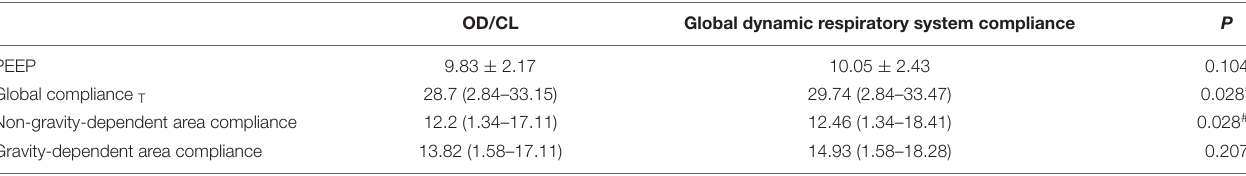
TABLE 2 | The comparison between the global compliance and regional compliance at PEEP EIT and PEEP C